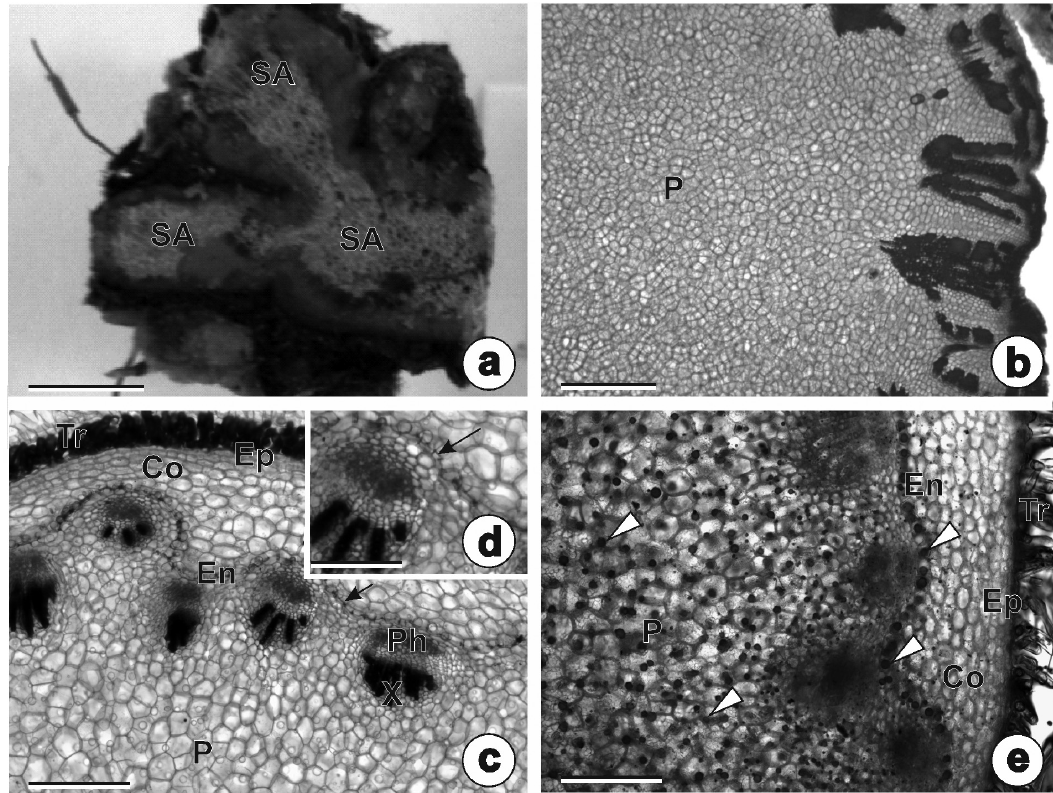
Figure 4 - Cross-sections of the rhizophore of adult Chrysolaena simplex . (a) Frontal view of the proximal region of the rhizophore with three interconnected stem axes. (b) Proximal region - general view showing the wide parenchymatous pith. (c) Detail of the vascular bundles and endodermis with Casparian strips (arrow). (d) Casparian strips (arrow). (e) Lipophilic droplets stained by Sudan III (arrows). Co: cortex; Ep: epidermis; En: endodermis; P: pith; Ph: phloem; SA: stem axes; Tr: non-glandular trichome; X: primary xylem. Scale bars, 1 cm (a) ; 0.05 cm (b) ; 500 μ m (c, e) ; 250 μ m (d) . See the colors in the online